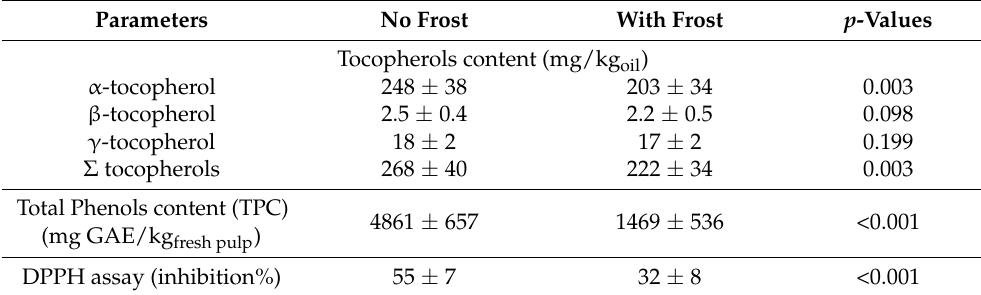
Table 3. Tocopherols contents, total phenols content, and DPPH radical scavenging inhibition of olives affected by frost and not affected by frost (mean ± standard deviation).